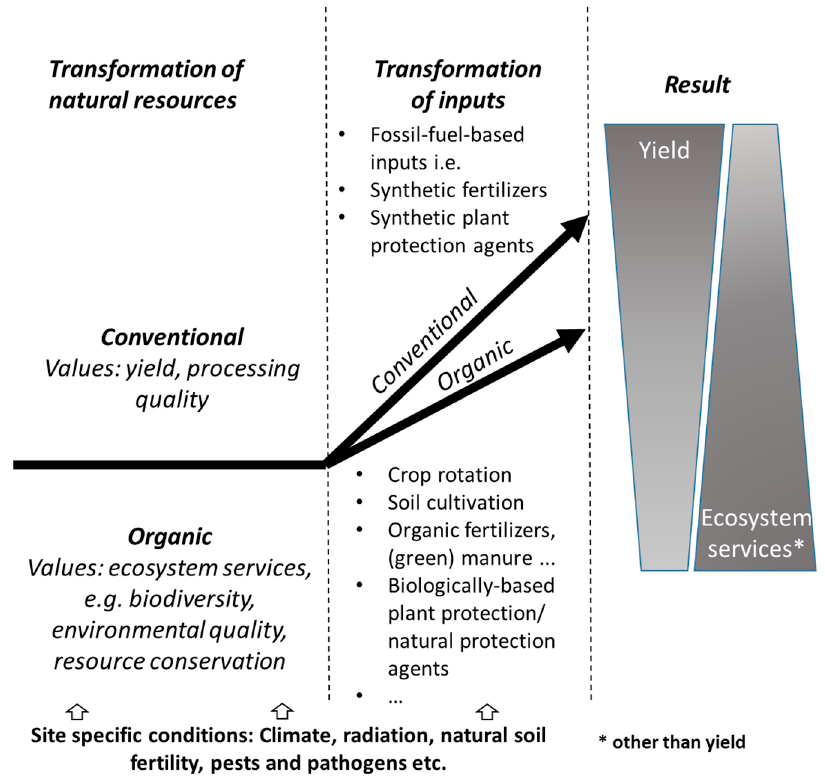
Figure 1. Simplified model to describe a cropping system as a process of transformation.